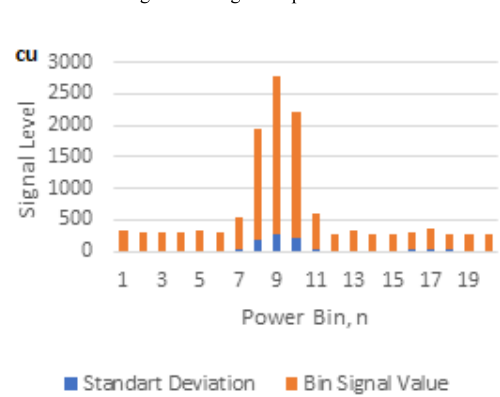
Fig. 7. Testing of 10 power bins.